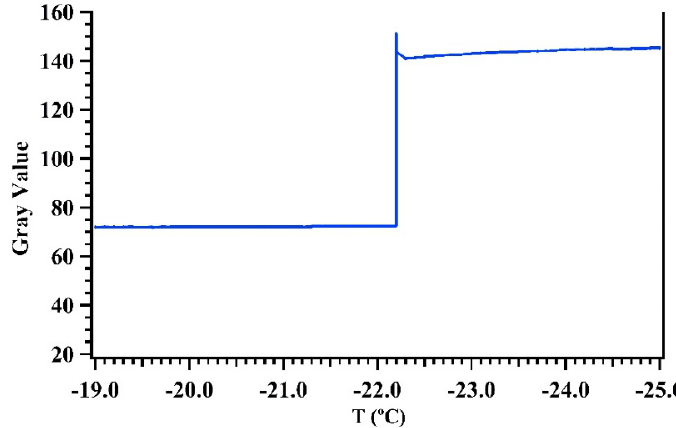
Figure 2. The gray value of a typical water droplet as a function of temperature during a cooling process.